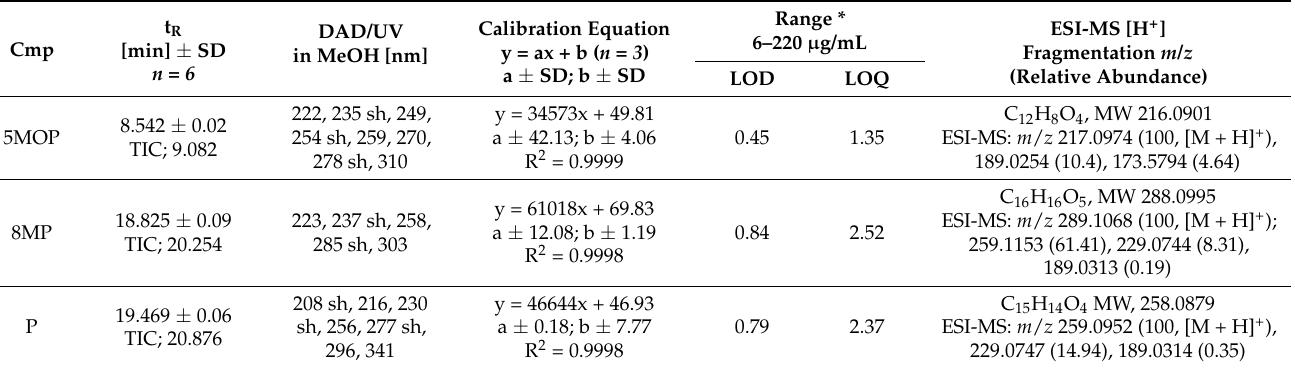
Table 2. Validation data for quantitative HPLC/DAD analysis and HR-ESI-MS assay for methoxyfu- ranocoumarins isolated from P. tauricum fruits.